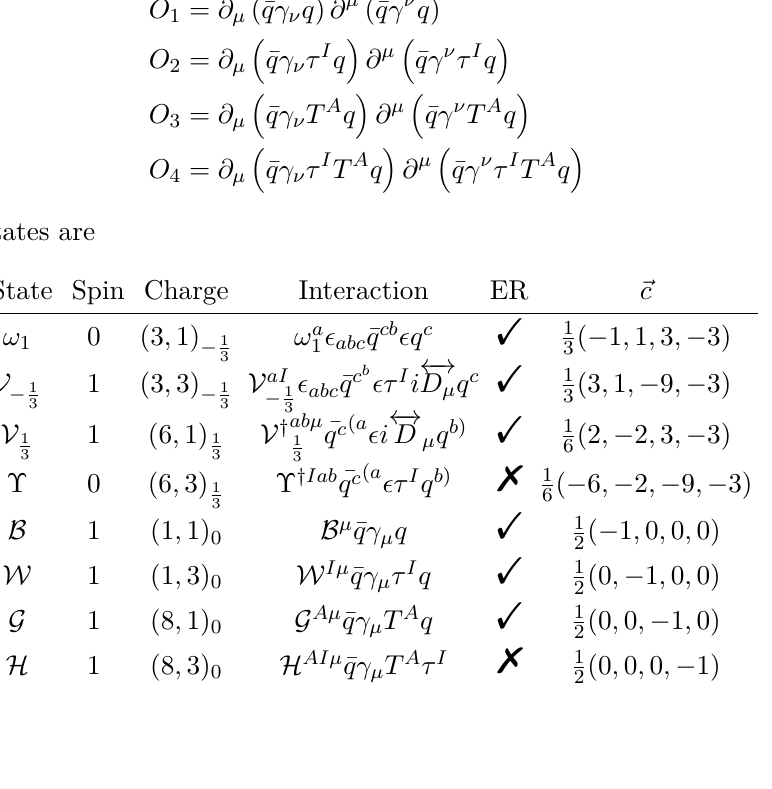
can be set. The /M 2 Ξ 1 Ξ 1